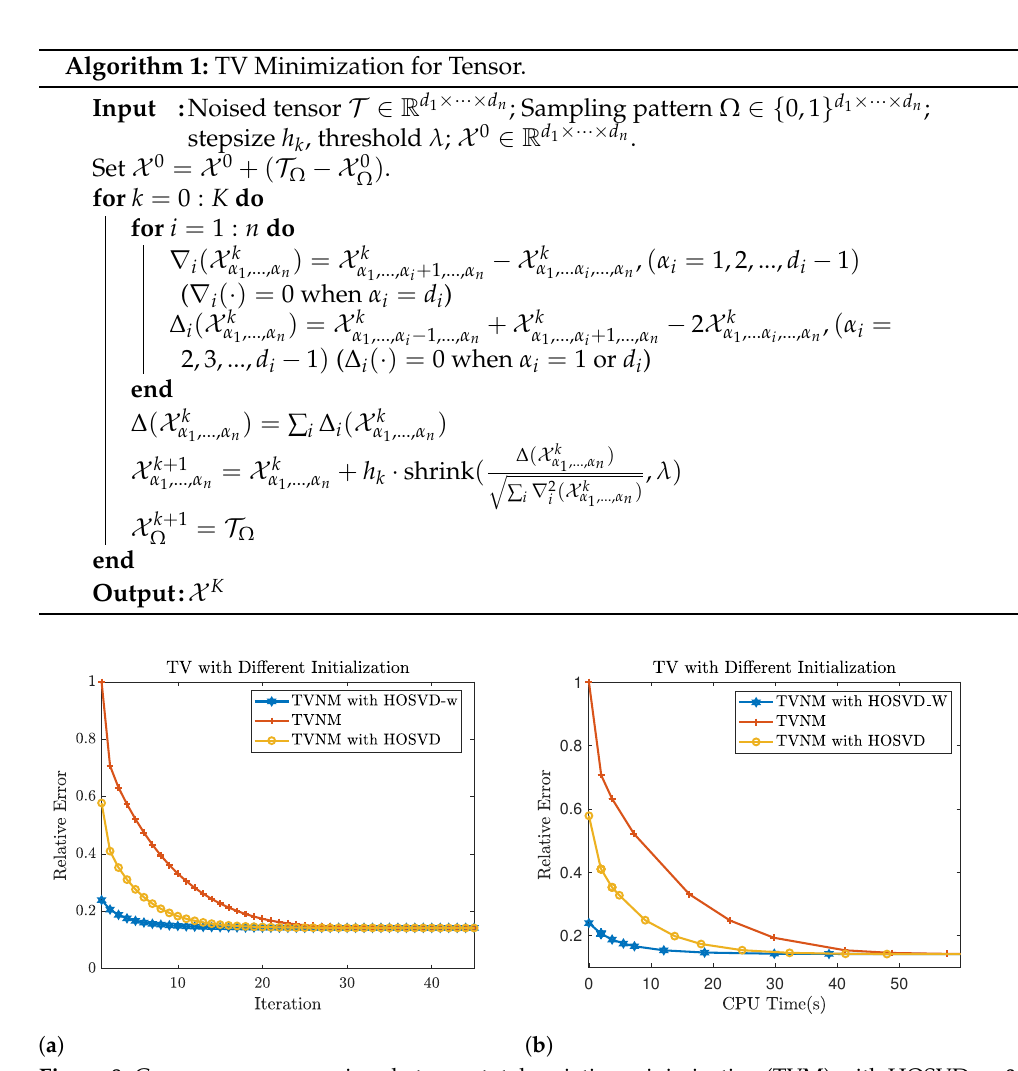
vs. number of (cid:107)T (cid:107) F